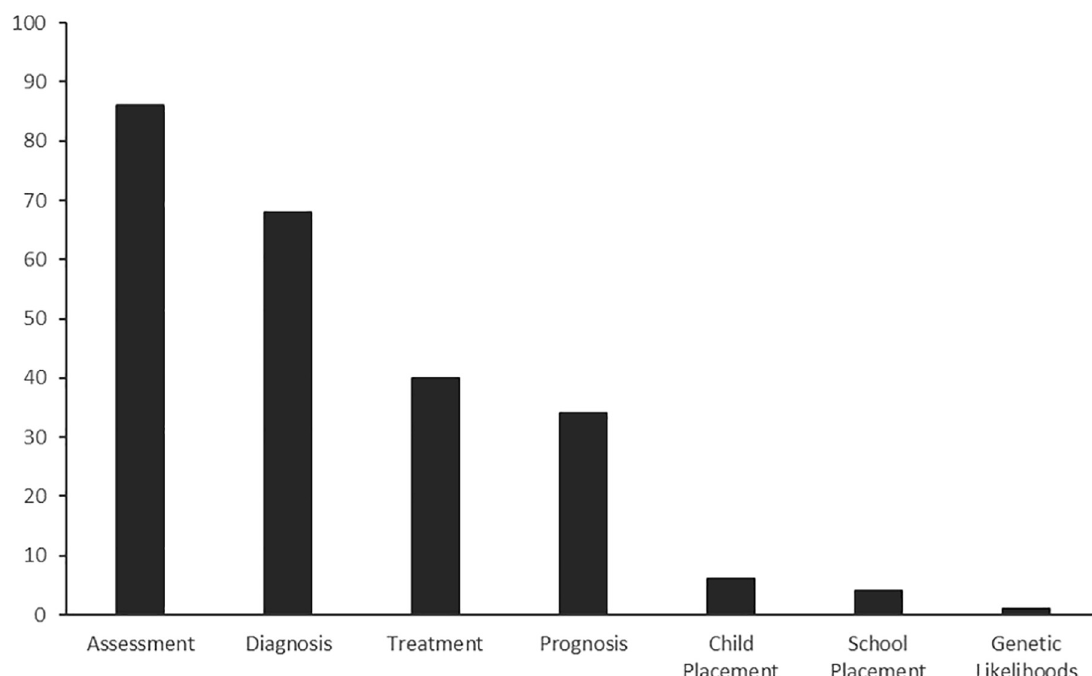
Fig 3. Number of studies reporting each broad decision type.